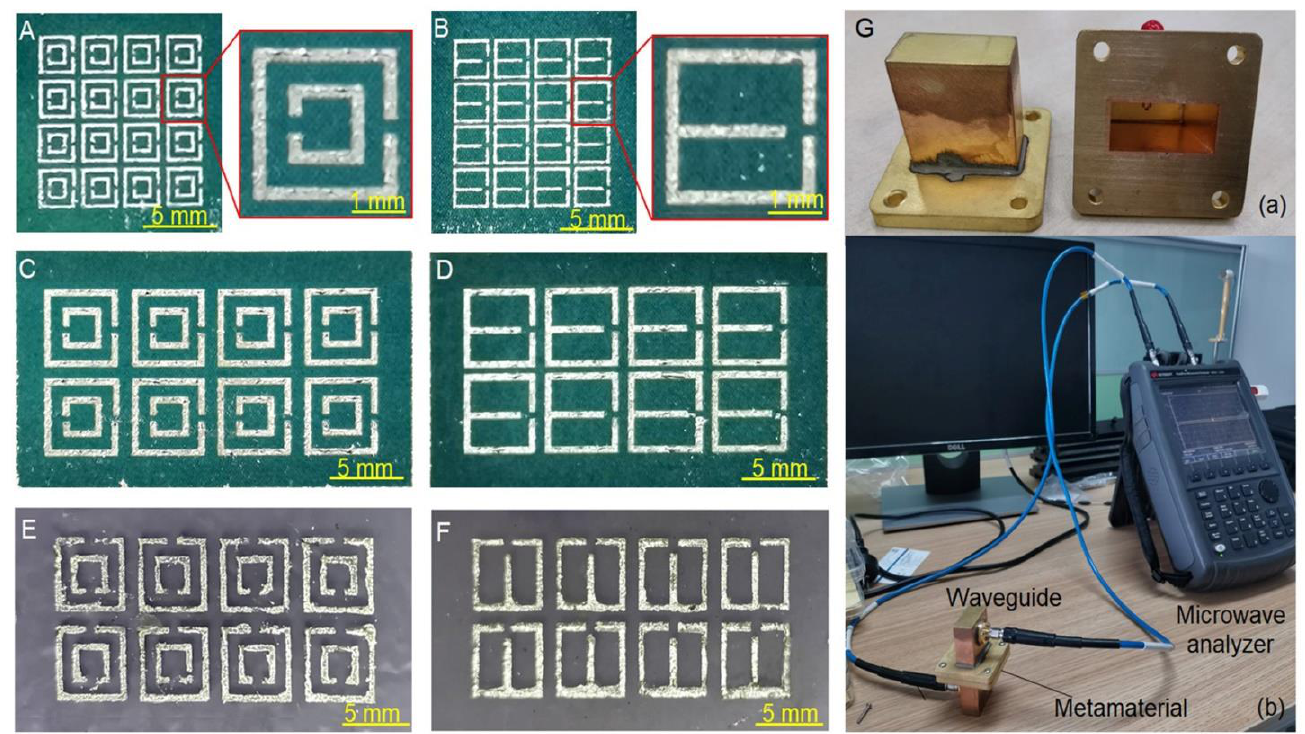
Figure 4. Fabrication and test of metamaterials based on liquid metal. ( A ) An array of 16 (4 × 4) DSRR units when the outer side length was 2.5 mm; ( B ) an array of 16 (4 × 4) ESRR units when the outer side length was 2.5 mm; ( C ) an array of 8 (2 × 4) DSRR units when the outer side length was 5 mm; ( D ) an array of 8 (2 × 4) ESRR units when the outer side length was 5 mm; ( E ) DSRR units on Ecoflex; ( F ) ESRR units on Ecoflex; ( G ) waveguide measurement setup: ( a ) a pair of waveguides; ( b ) assembly drawing.